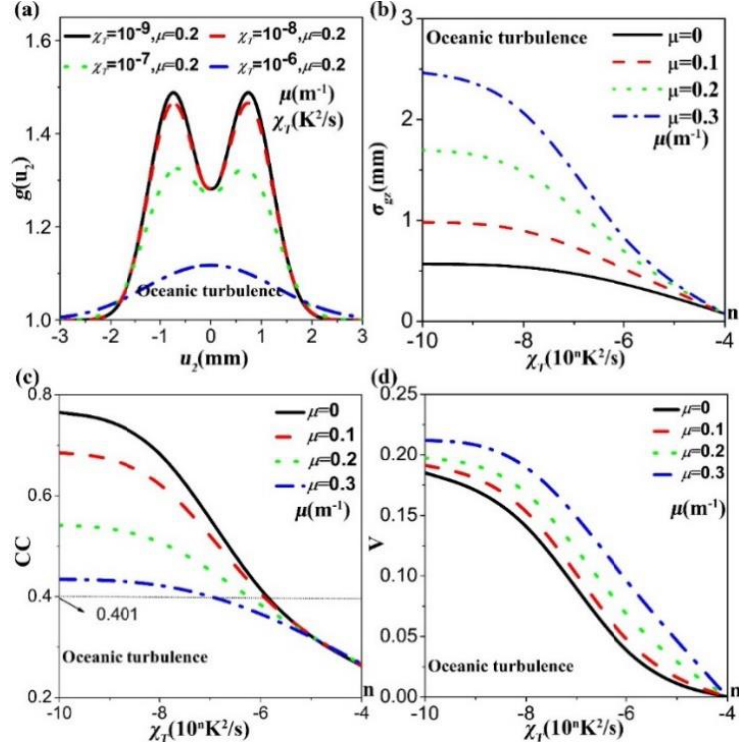
Figure 4. ( a ) Image of the double slits; ( b ) Changes of coherence width with the parameter χ T ; ( c ) Dependence of CC on the parameter χ T ; ( d ) Dependence of V on the parameter χ T